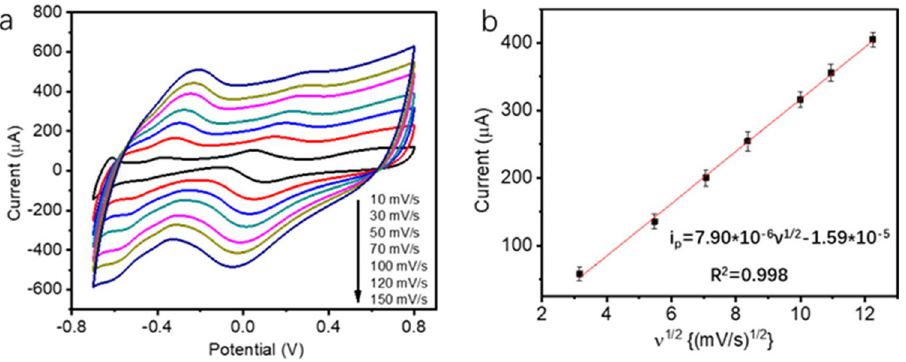
Figure 4. ( a ) CVs of PtNi alloy-graphene/GC electrode in 0.1 M PBS with 10 mM glucose at various scan rate from 10 to 150 mV/s. ( b ) Corresponding plot of peak current at 0.1 V vs. the square root of the scan